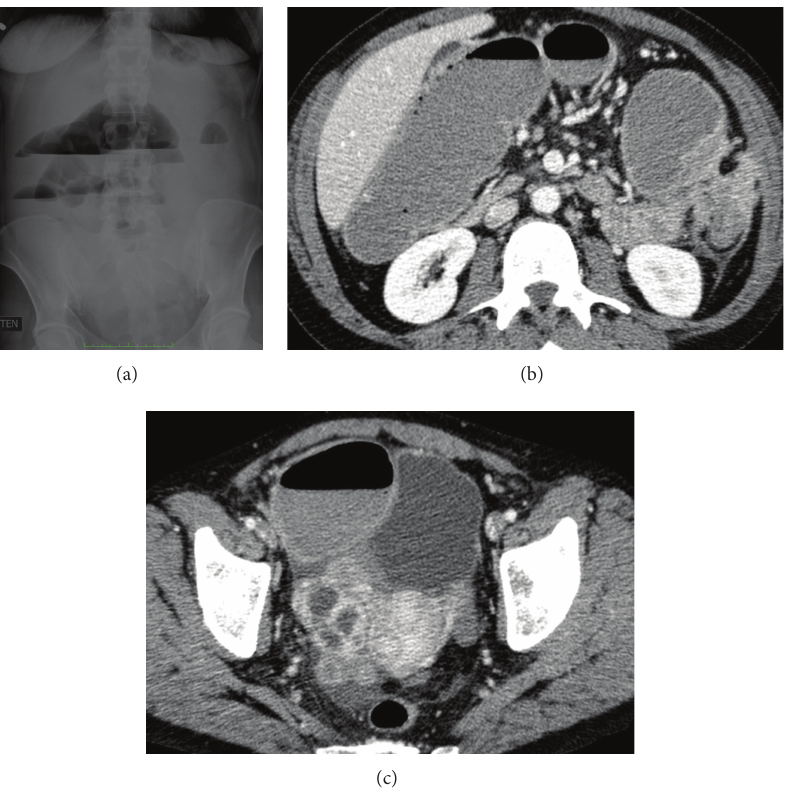
Figure 1: (a) An abdominal radiograph reveals multiple fluid levels and a dilated bowel segment (arrow heads), (b) a CT scan from upper abdomen exhibits dilated colon structure (black arrowheads), narrowed colonic segment (white arrowhead), and extraluminal infiltration (arrow), and (c) A CT scan from lower abdomen exhibits cystic involvement in right ovary (arrowheads) as well as enlarged colon (asterisk).